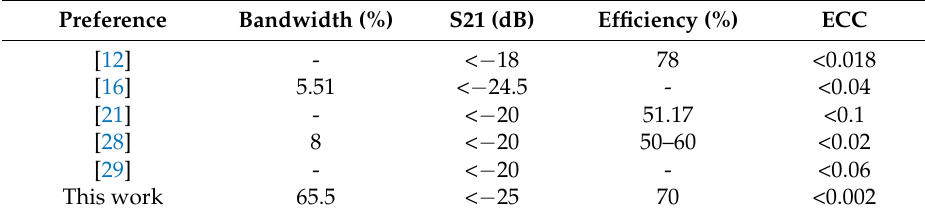
Figure 21. Maximum gain over frequency. Table 3. Comparison of the antenna with previous